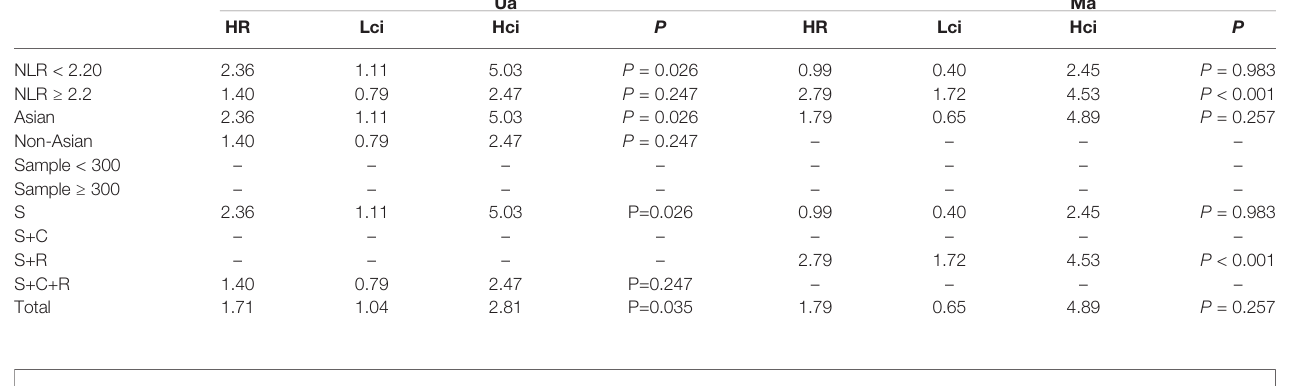
TABLE 4 | The results of the subgroup analysis for neutrophil – lymphocyte ratio (NLR) and progression-free survival are summarized below. Ua